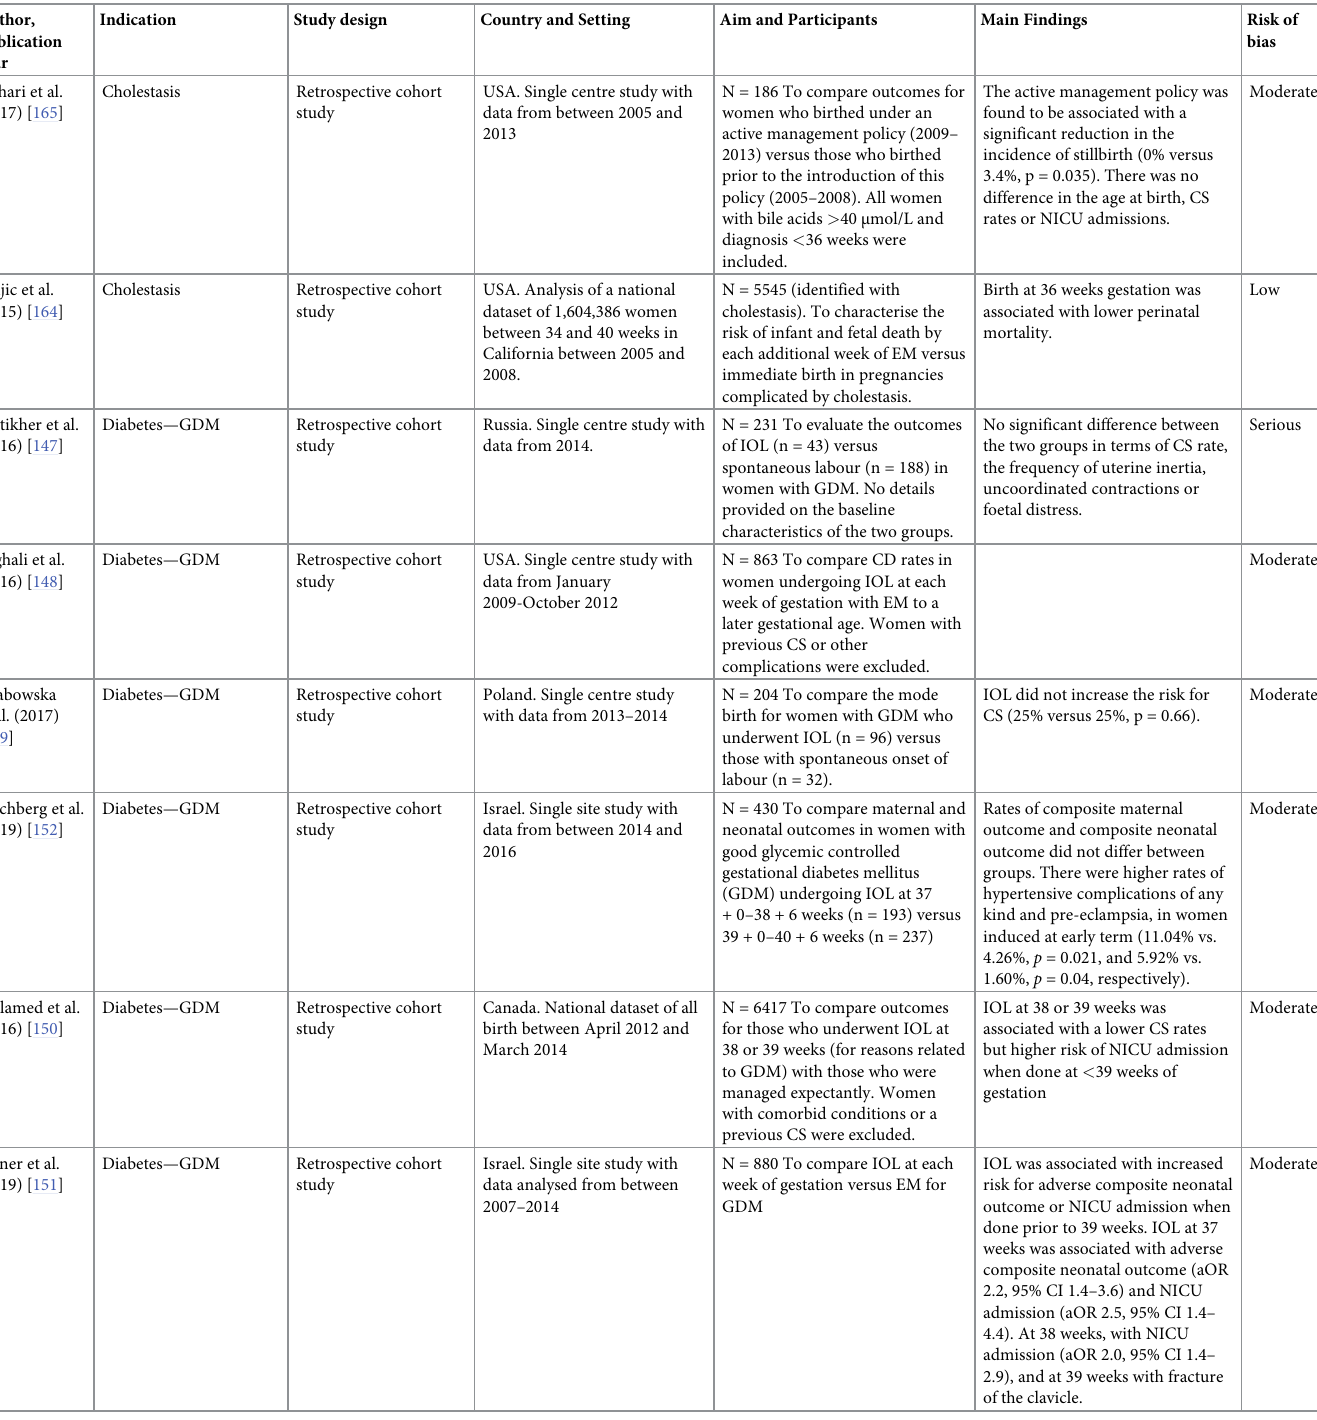
Table 2. Included non-randomised